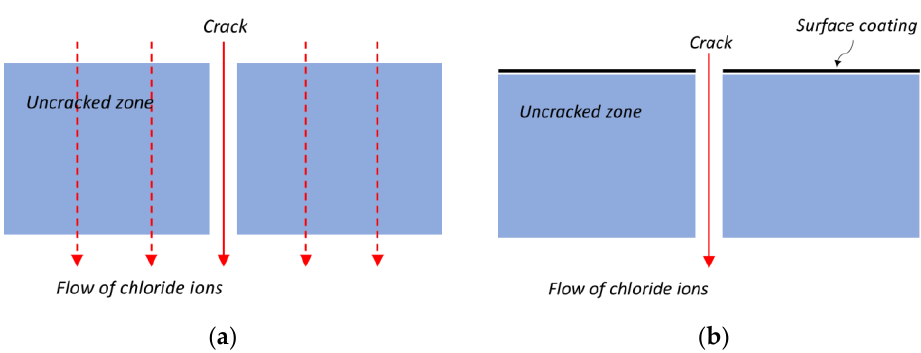
Figure 2. Transport paths of chloride ions in uncoated and coated specimens: ( a ) uncoated specimen and ( b ) coated specimen.